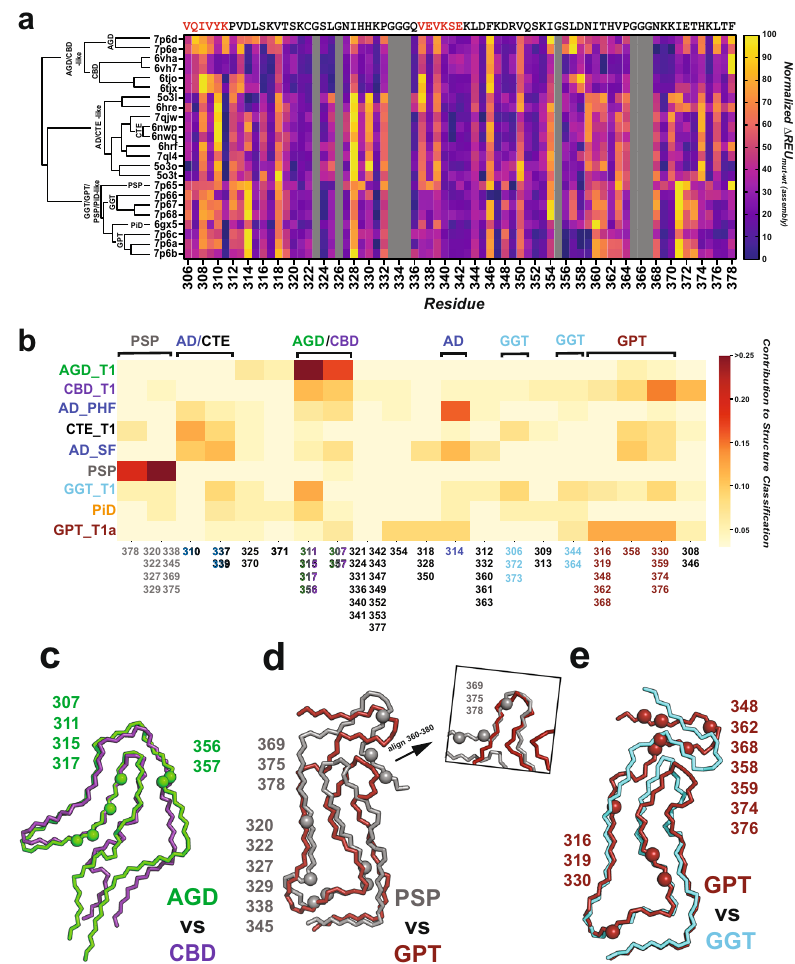
Fig. 6 | Feature classi fi cation clusters structural polymorphs by hotspot interactions and folds. a Dendrogram produced by hierarchical/agglomerative clusteringusingWard ’ smethodoftau fi brilstructuresbasedonnormalizedinsilico Δ REU assembly mut (cid:1) wt values determined by the alanine scan, displayed next to the plot of normalized Δ REU assembly mut (cid:1) wt values. Scale is colored in plasma from yellow (highest in silico Δ REU assembly mut (cid:1) wt ) to purple (lowest in silico Δ REU assembly mut (cid:1) wt ) for all available tau ex vivo fi bril structures from AD, CBD, AGD, PSP, GPT, GGT, and PiD,